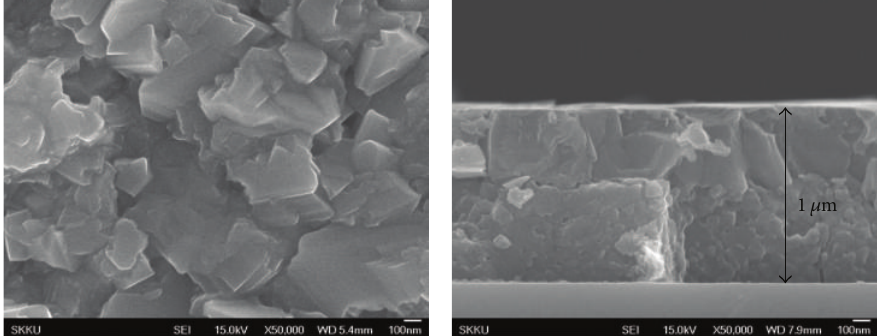
Figure 4: SEM images of CZTS thin film annealed in sulfur vapor at 530 ∘